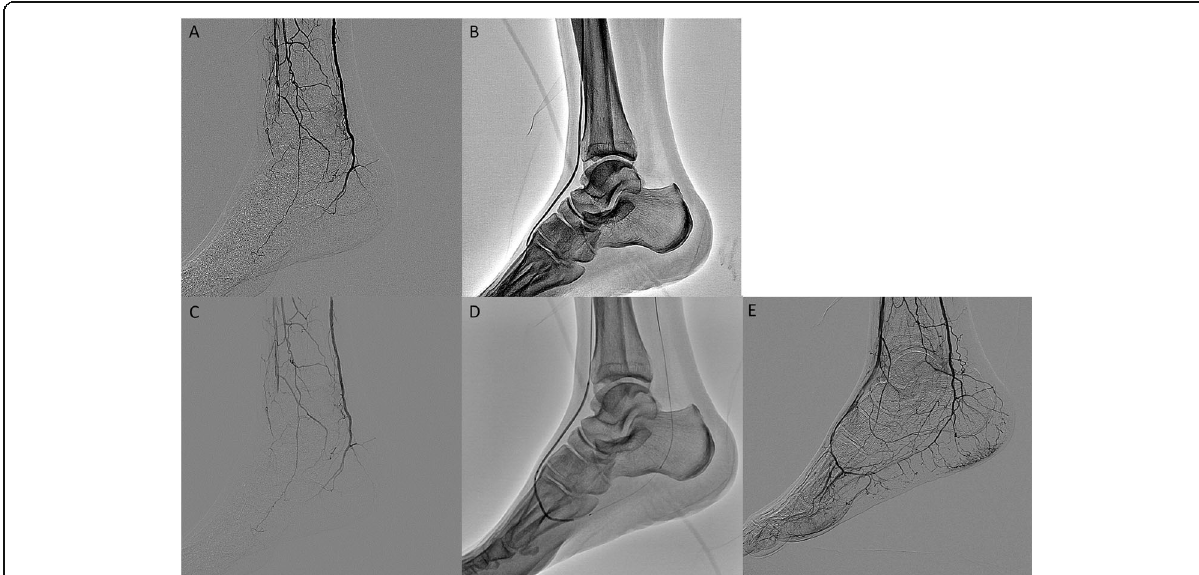
Fig. 2 Additional pedal artery angioplasty in case 1. a Baseline angiography showing total occlusion from the anterior tibial artery (ATA) to the dorsalis pedis artery (DPA) in our hospital. b The balloon was dilated from the DPA to the ATA. c Angiography showed insufficient blood flow to the forefoot after ballooning on the DPA and ATA. d Additional balloon angioplasty was performed in the occluded pedal artery. e Sufficient blood flow was obtained after additional pedal artery angioplasty